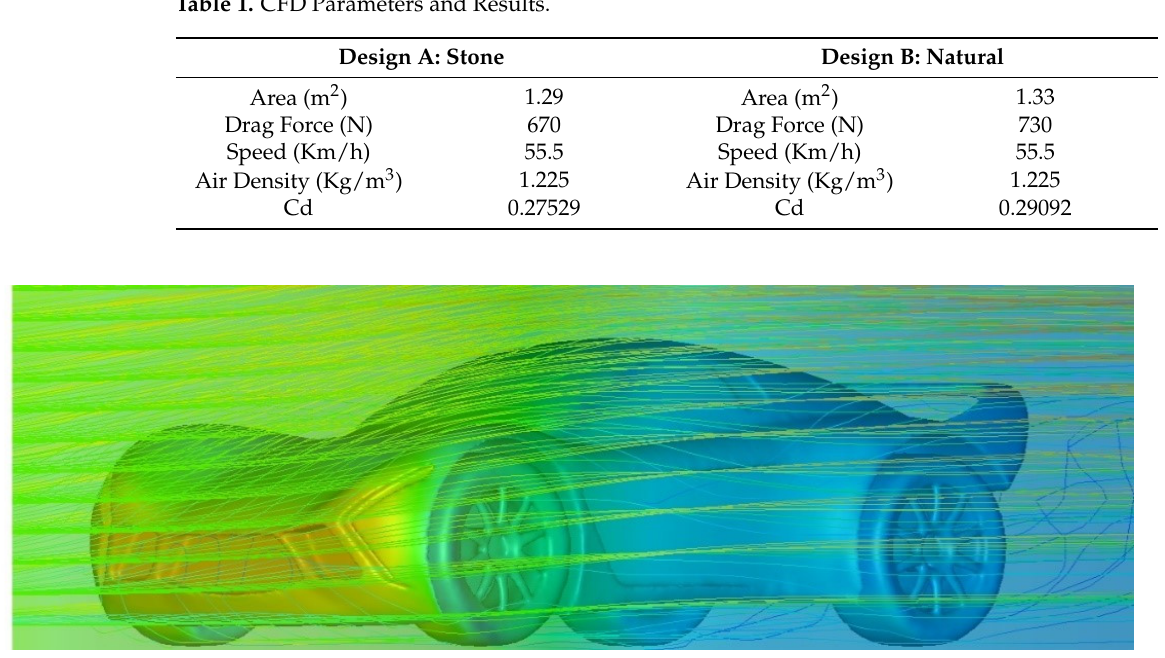
Figure 33. Stone concept CFD Analysis.